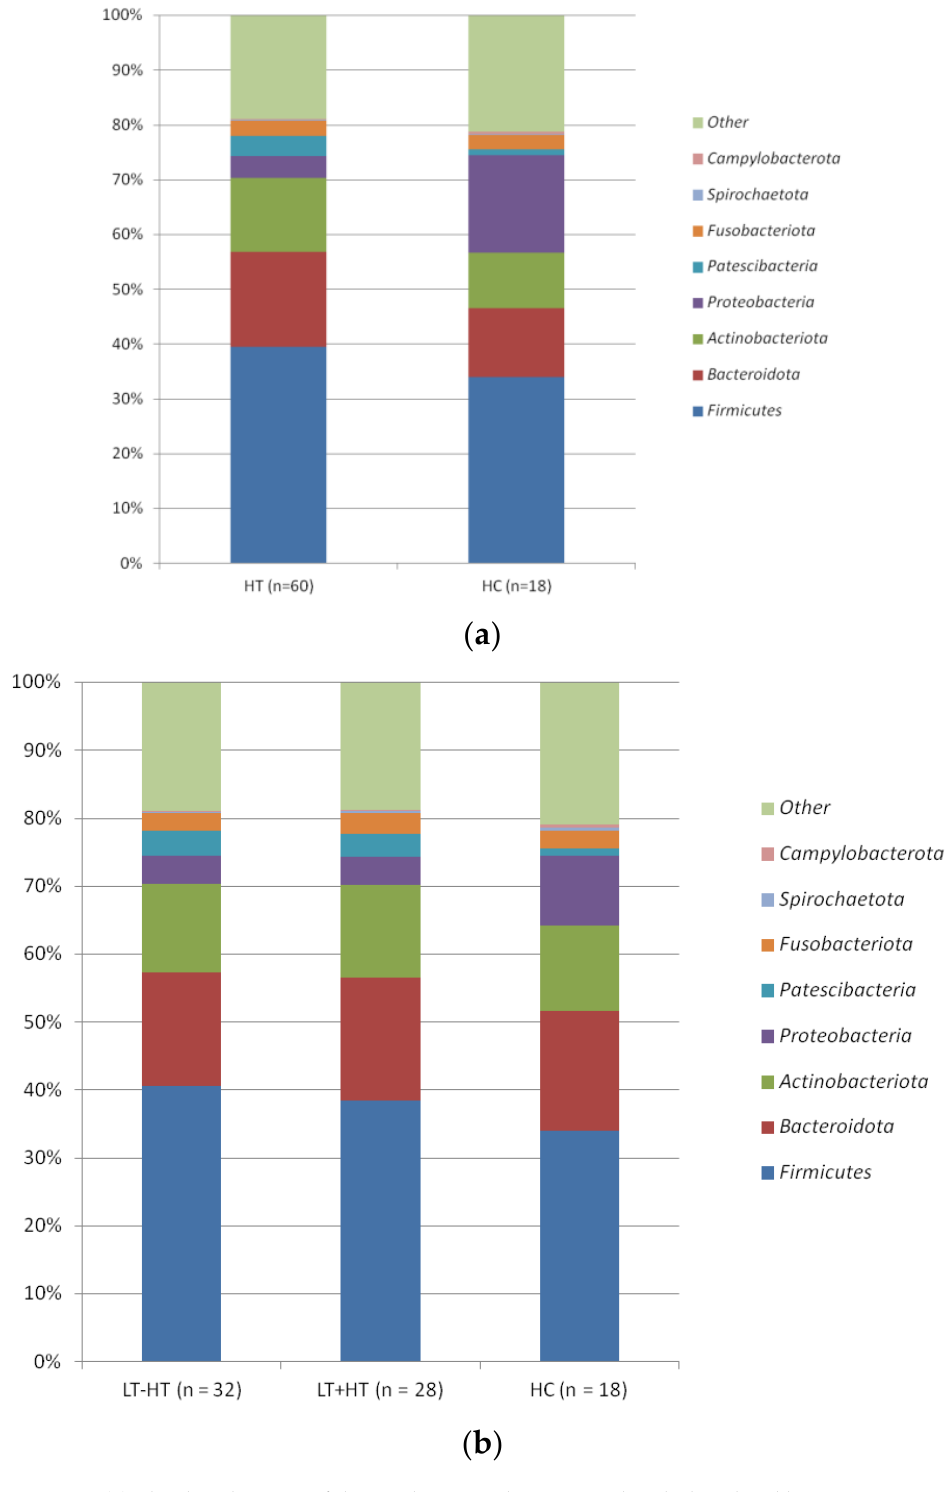
Figure 2. ( a ) The distributions of the predominant bacteria at the phylum level between HT and HC groups. (HT: Hashimoto’s thyroiditis. HC: Healthy control). ( b ) The distributions of the predominant bacteria at the phylum level between LT-HT, LT + HT, and HC groups (HT: Hashimoto’s thyroiditis. LT + HT: Euthyroid HT treated with levothyroxine (L-T4). LT-HT: euthyroid HT without L-T4 therapy. HC: Healthy control).